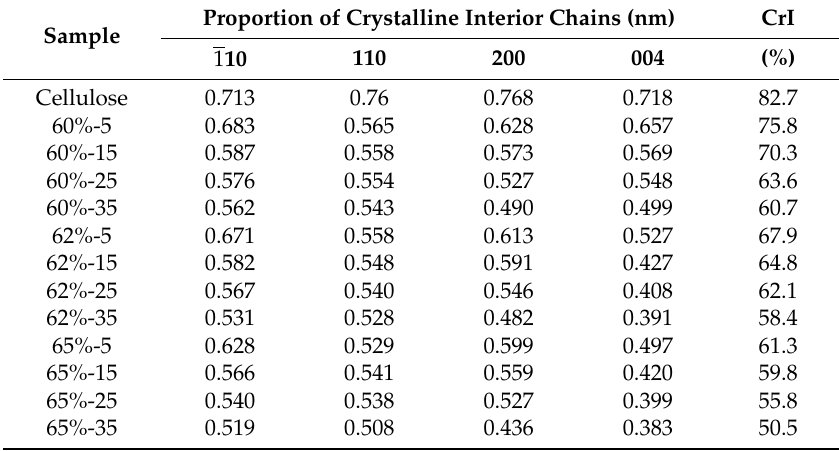
Table 2. The proportion of crystalline interior chains and the crystalline index of cellulose samples.